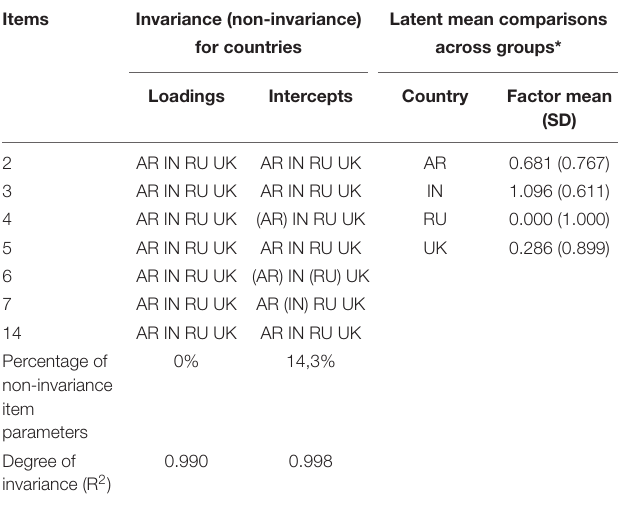
TABLE 3 | Approximate measurement invariance (non-invariance) for groups and comparison of aligned factor means of the Short Home Attachment Scale across